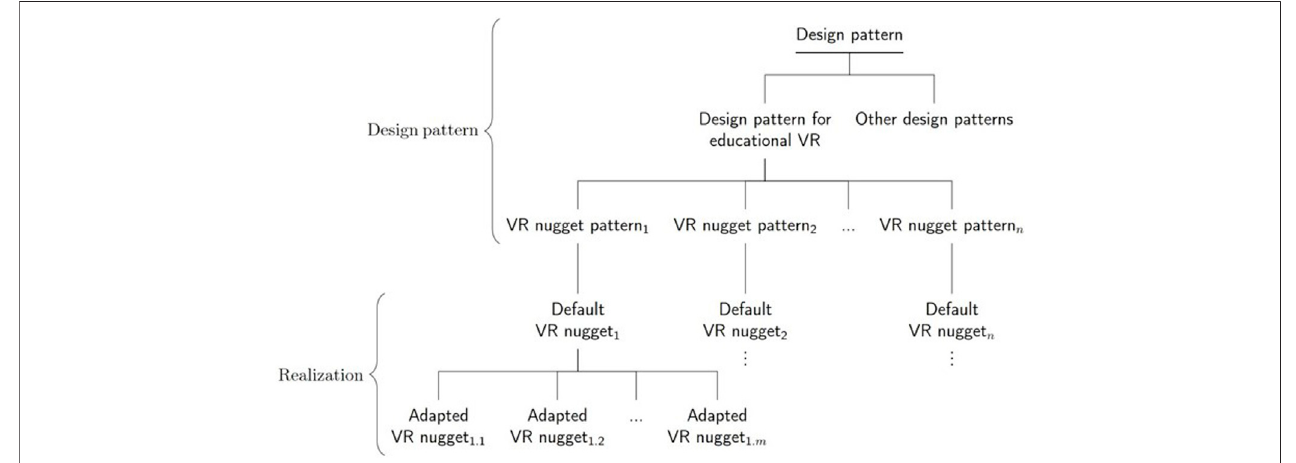
FIGURE 7 | The hierarchy graph shows the connection of VR nuggets and patterns from Figure 3 adjusted by the concepts of default and adapted VR nuggets . Here, we also differentiate between a design pattern and realizations of design patterns.